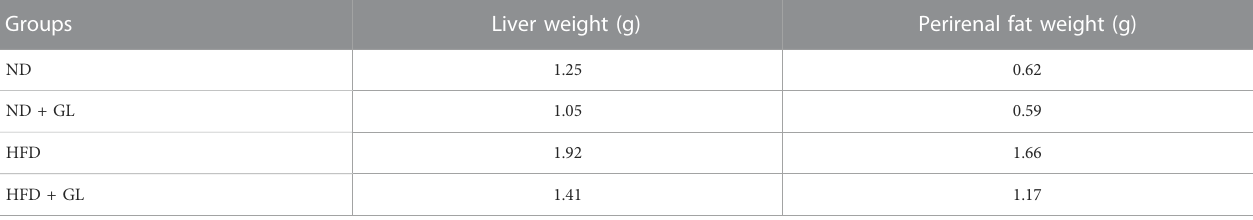
TABLE 6 G. lucidum (GL) attenuates perirenal fat accumulation in the liver weight of mice fed a high-fat diet (HFD). Groups